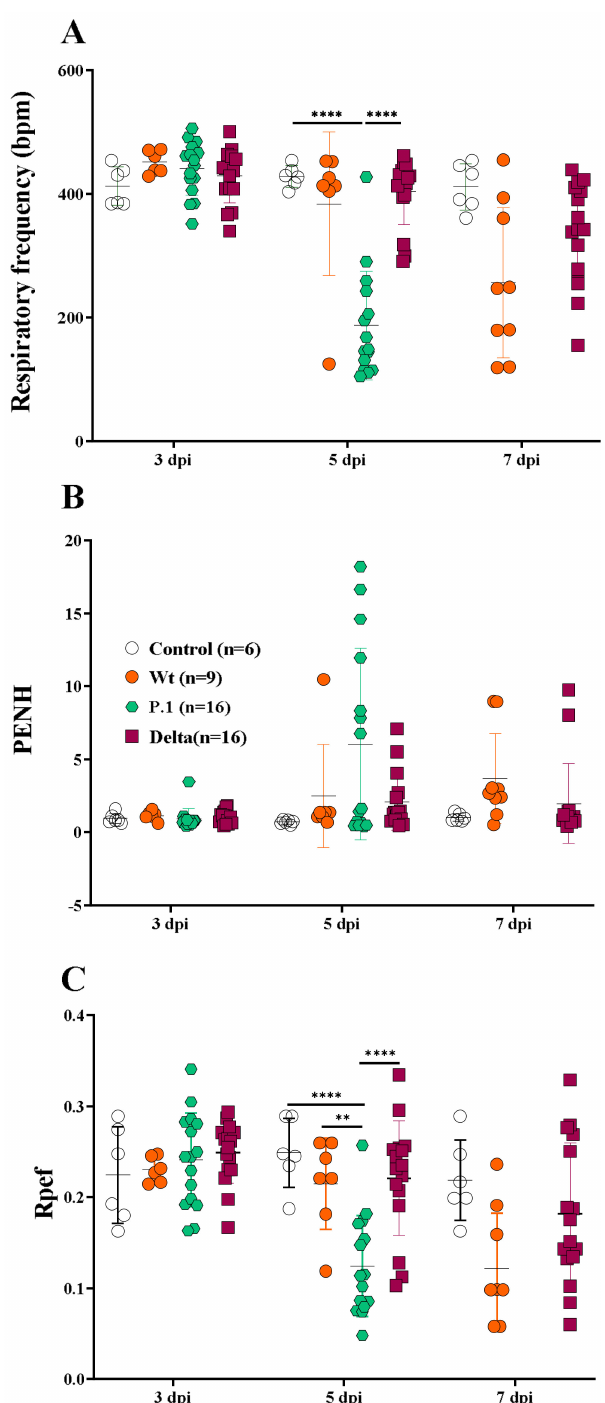
Figure 2. The whole-body plethysmography indicates severe lung dysfunction in the P.1-infected mice. The evaluation of lung function for respiratory frequency ( A ), enhanced pause (Penh) ( B ), and exhalatory flow curve (Rpef) ( C ) in the Wt strain and the P.1 and Delta-infected K18-hACE mice. A multiple t test was applied, using GraphPad Prism 8.0; p < 0.05, was considered significant (** p ≤ 0.005 and **** p ≤